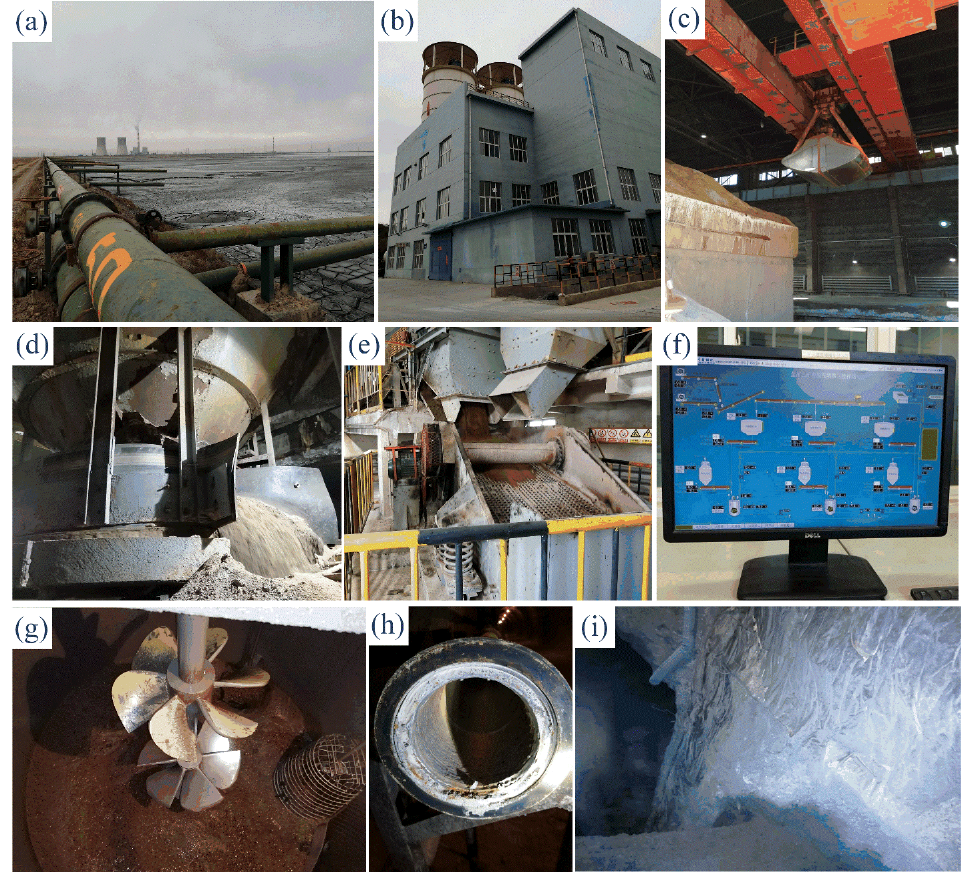
Figure 5. (Source: Gansu Jinchuan Group Co., LTD, Jinchang, China) Rod grinding paste backfill system configuration diagram of Jinchuan group company: ( a ) tailings pond; ( b ) outdoor view of backfill station; ( c ) Gobi aggregate yard; ( d ) disk feeder feeding; ( e ) shaker; ( f ) control systems; ( g ) double spiral blades inside the stirring drum; ( h ) ceramic lined tubes; and ( i ) the backfill body in the approach.